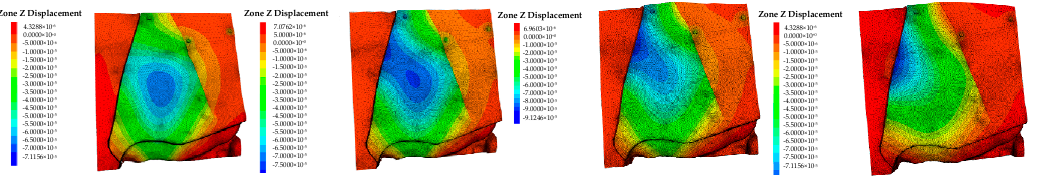
Figure 10. Cloud diagram of vertical displacement of the top slab when the number of overhanging slates is di ff erent